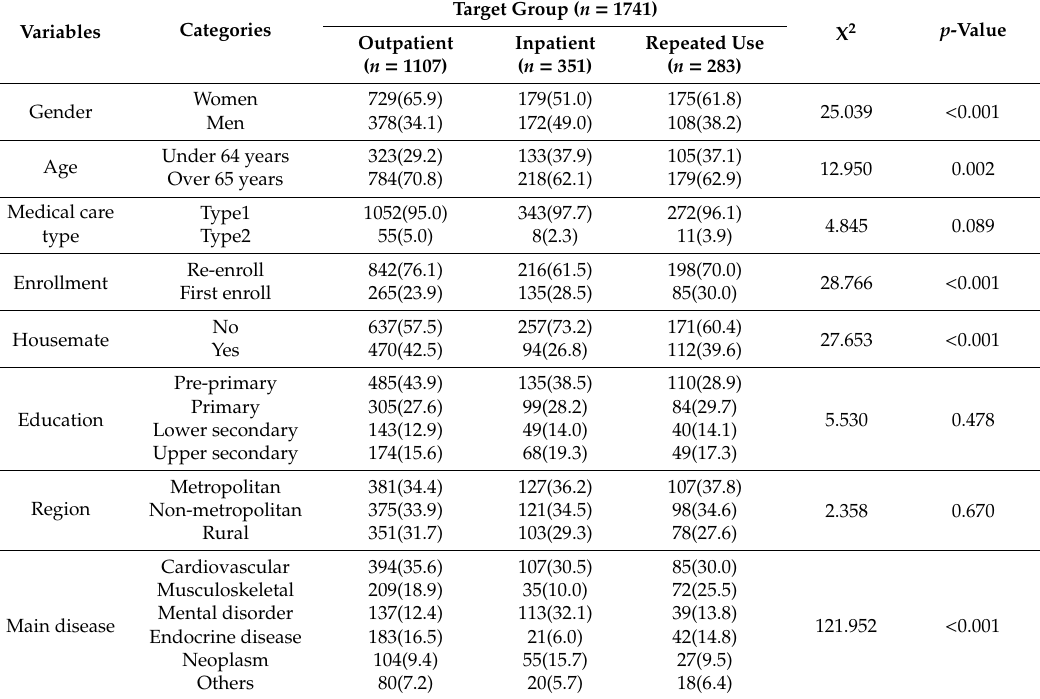
Table 1. General characteristics of clients enrolled in community-based case